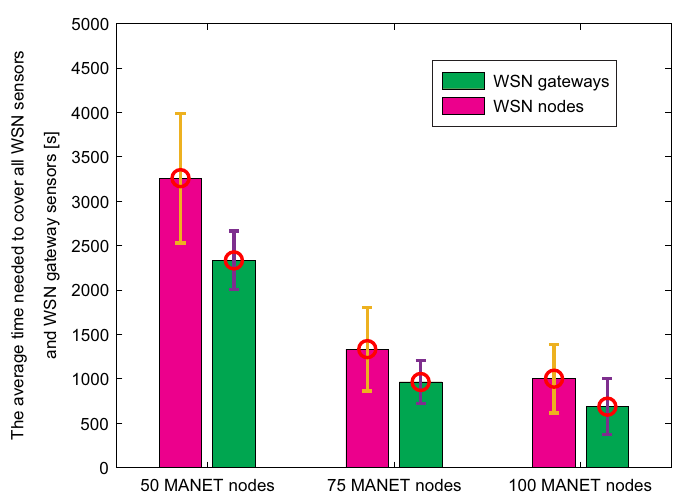
Figure 24. The average time needed to cover all WSN sensors and WSN gateway